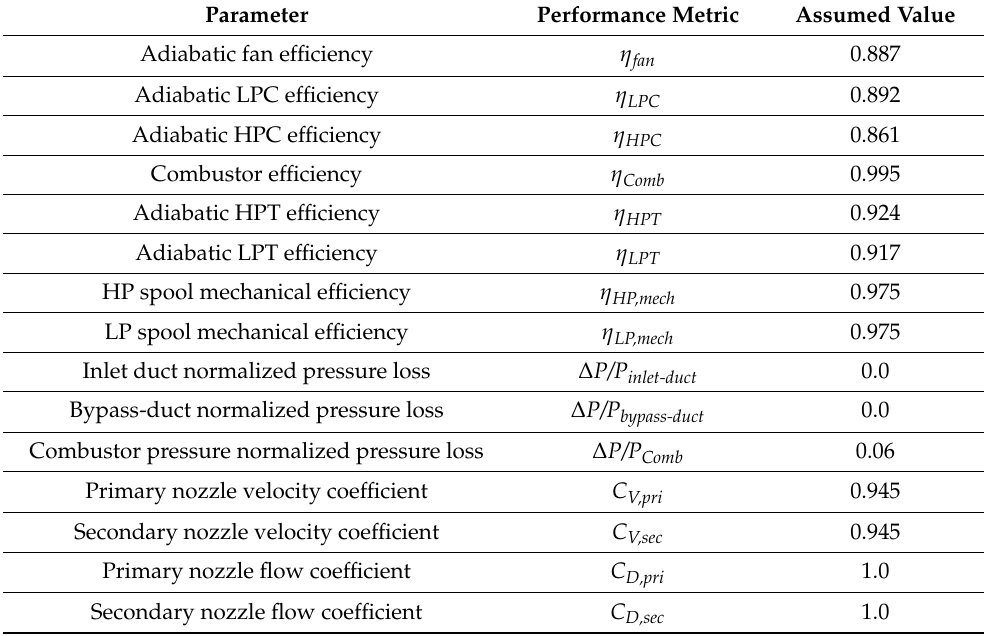
Table 2. Design Point (DP) engine component assumptions.